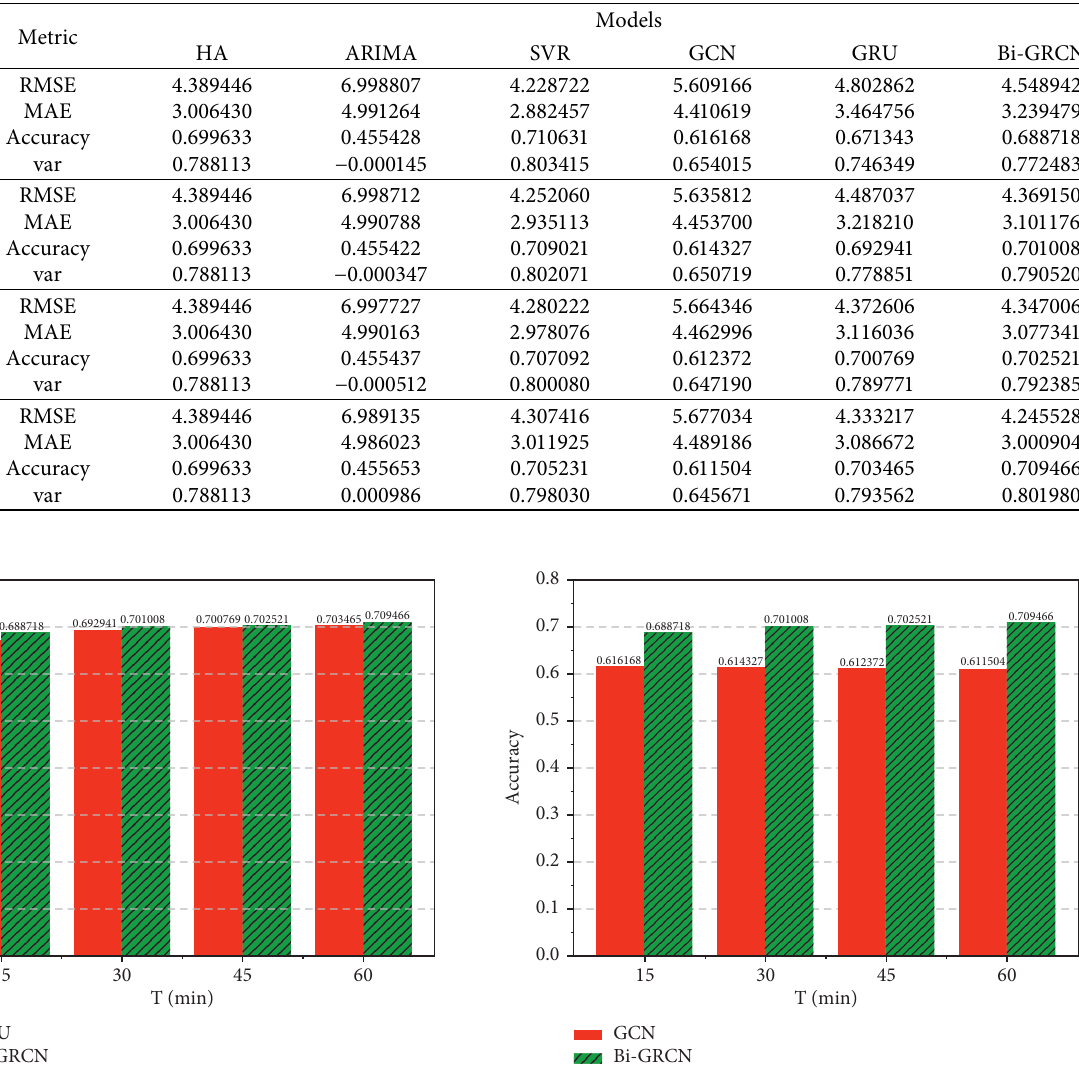
Figure 9: Accuracy comparison between GRU and Bi-GRCN. Figure 10: Accuracy comparison between GCN and